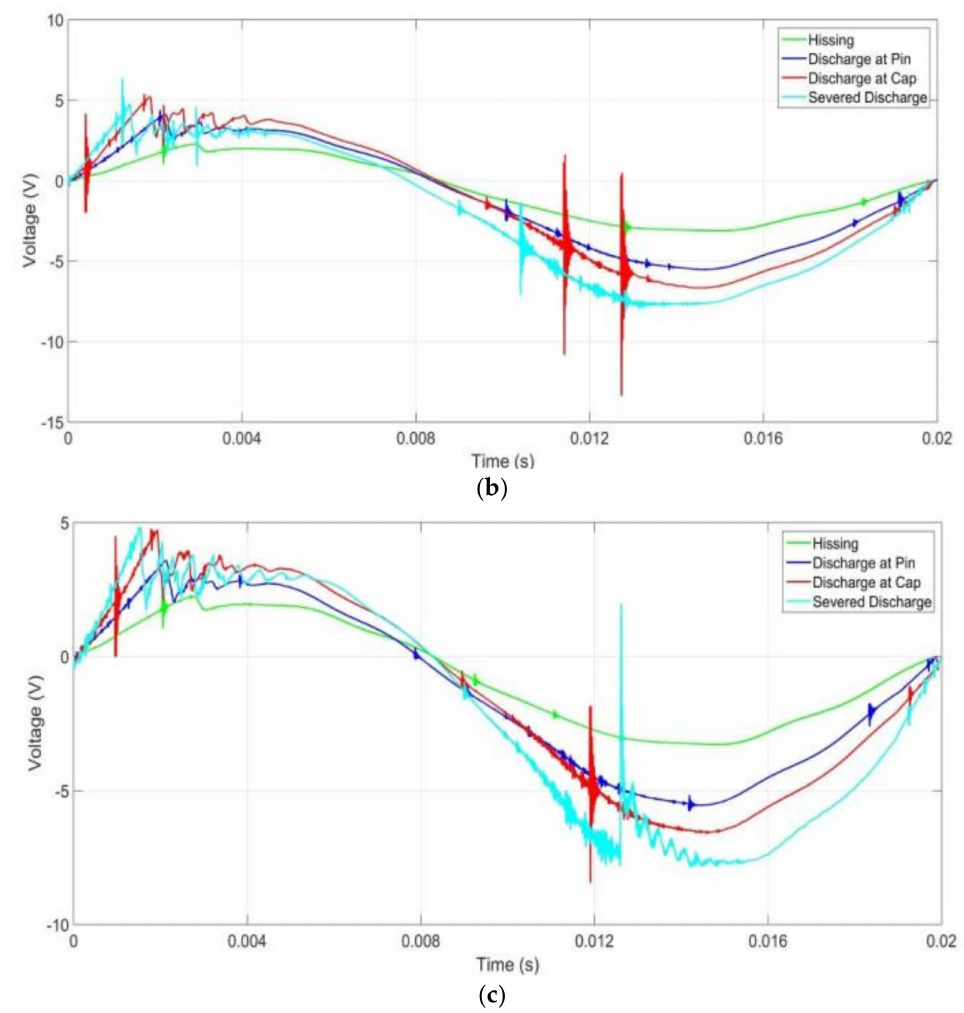
Figure 7. UV signals for insulator samples with dry surface conditions and without contaminations: ( a ) Group A; ( b ) Group B; ( c ) Group